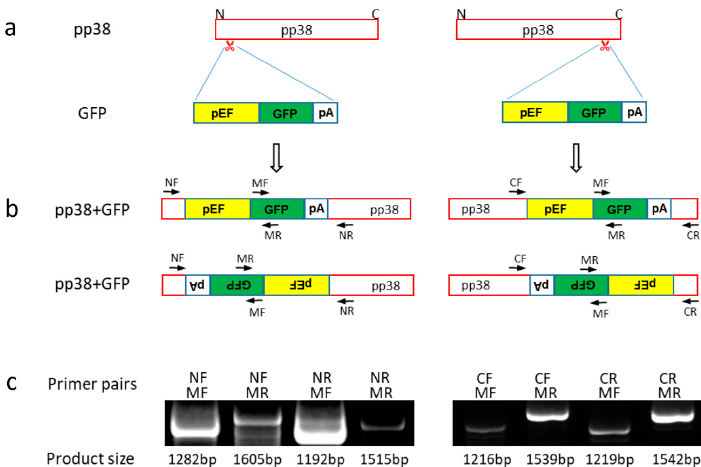
Figure 4. Knock-in of green fluorescent protein (GFP) expression cassette into pp38 of HP8-Cas9. ( a ) Schematics of GFP expression cassette and pp38 with the gRNA targeting sites at N and C terminus.